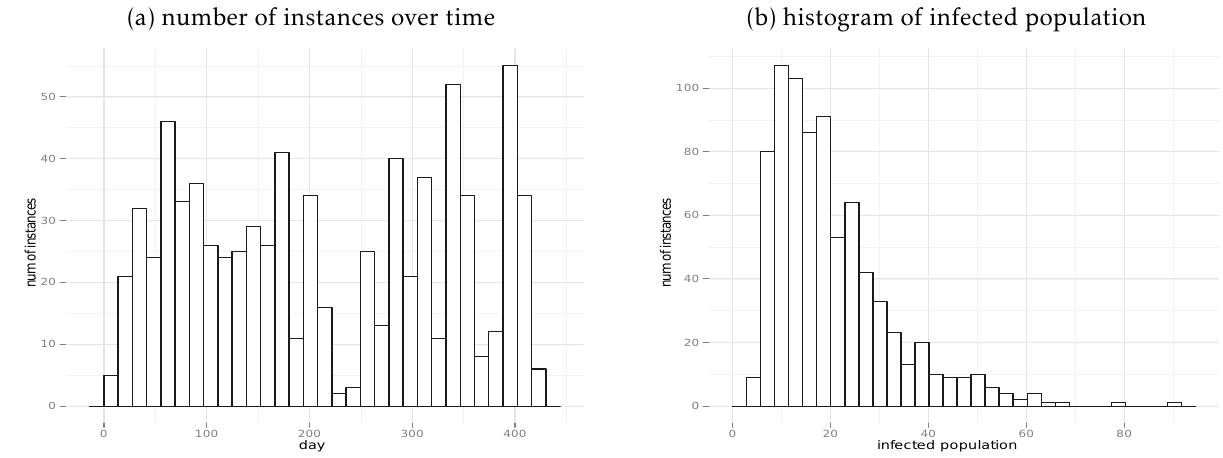
Figure 3. (a) Number of n-gram infected instances extracted by our method. (b) Histogram of infected population per instance. The n-gram with the largest population is “osama-bin-laden” which infects 91 members.